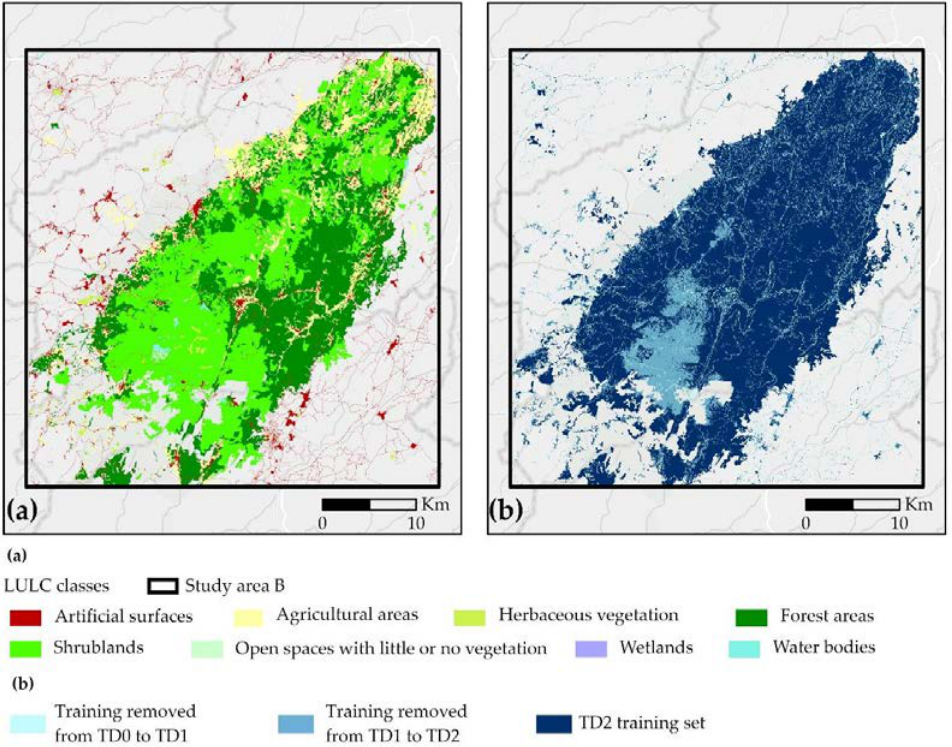
Figure 8. Training data for study area B: ( a ) Shows TD0 training set. ( b ) Shows the regions excluded from TD0 to obtain TD1 (light blue) as well as the regions removed from TD1 to obtain TD2 (a medium shade of blue) and TD2 (dark blue).